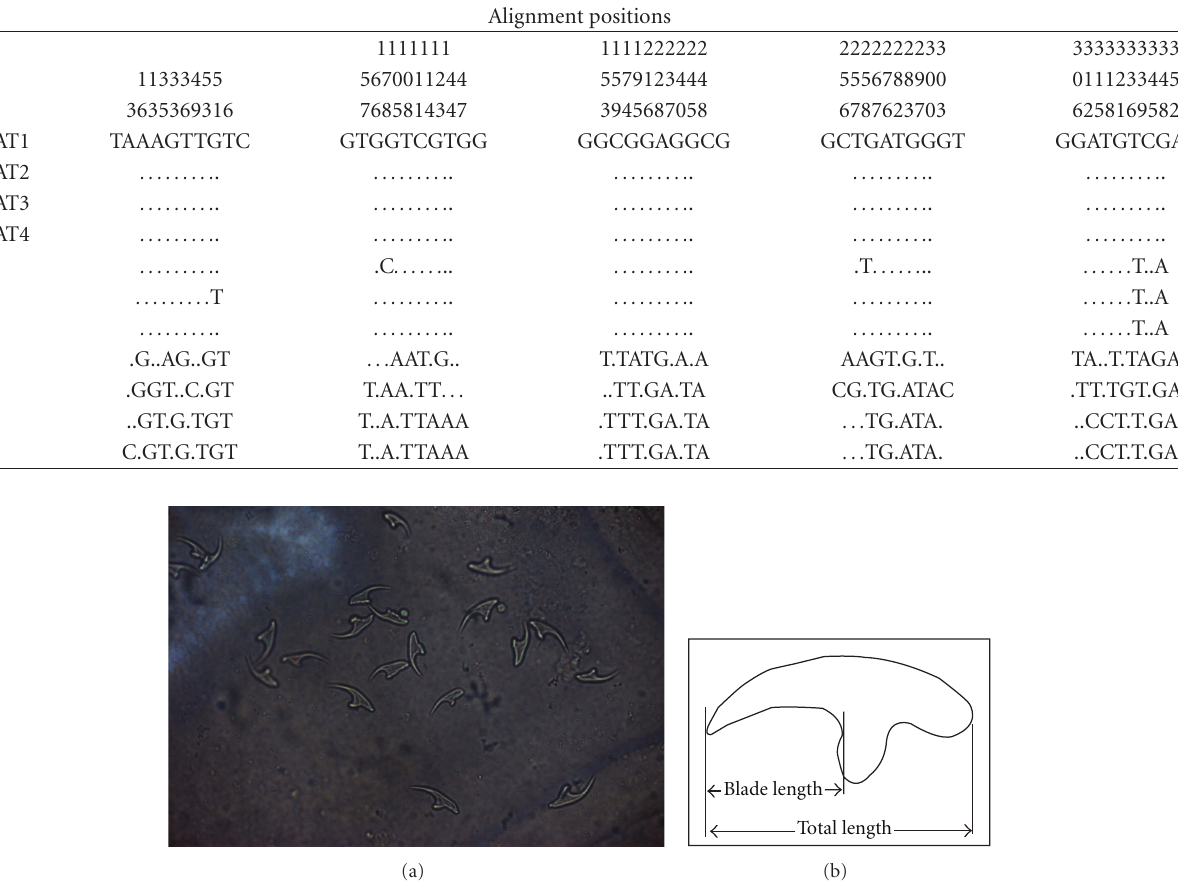
Table 3: Alignment of the variable sites in the partial cox1 mitochondrial gene of the isolates of E. granulosus sensu lato evidenced in the goats (goat 1–4) examined in Central Italy with available sequences for other genotypes deposited in GenBank (E.g1–7).